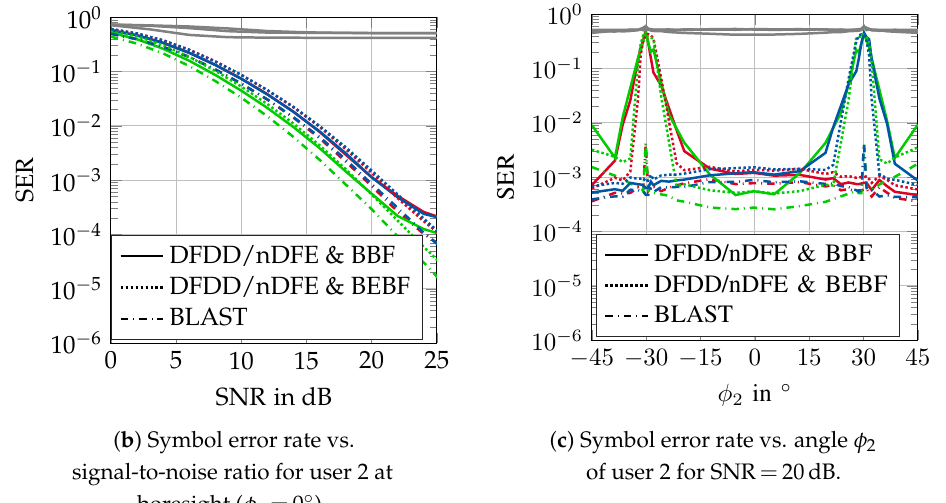
of user 2 for SNR = 20dB.